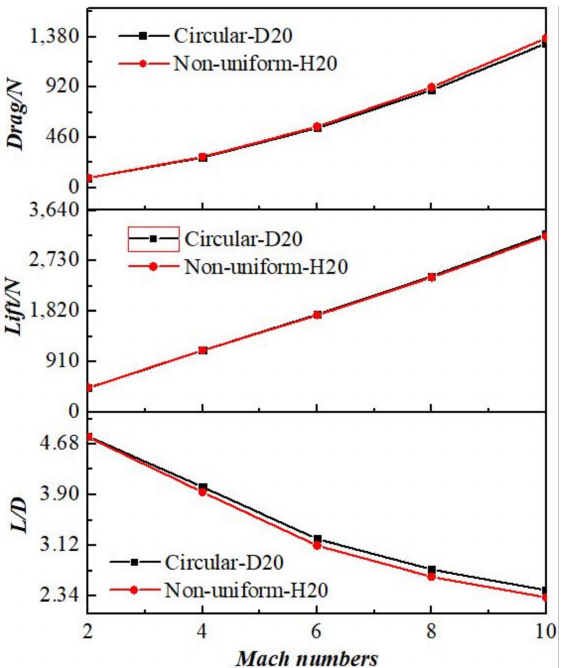
Figure 19. Aerodynamic performance of different blunt profiles with various Mach numbers (diame- ter/height: 20